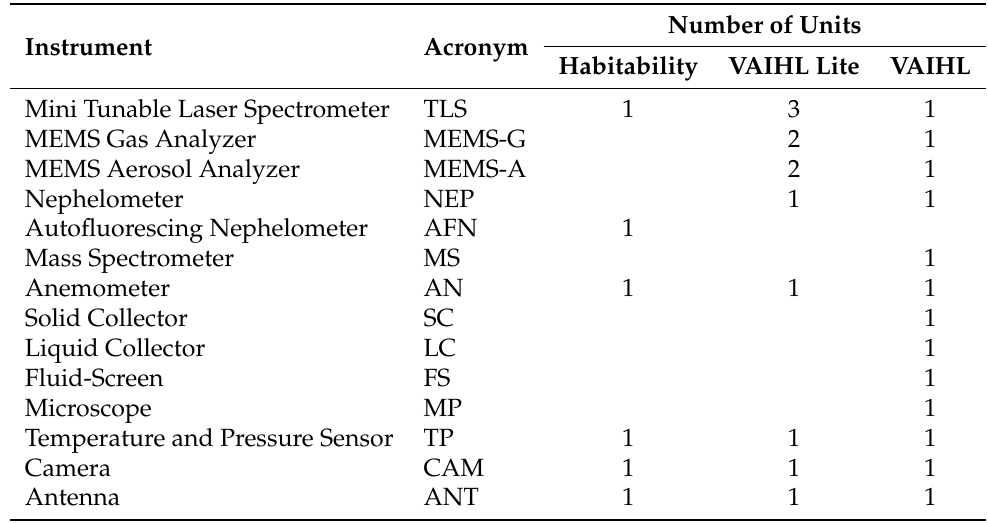
Table 1. VLF instrument summary. For a detailed discussion of the instruments and science behind the proposed VLF mission architecture, see [34].